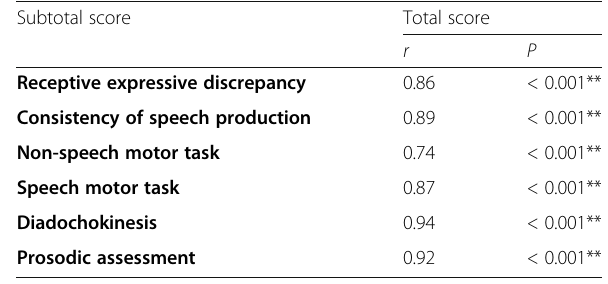
Table 4 Correlation between subtotal and total scores of CAS